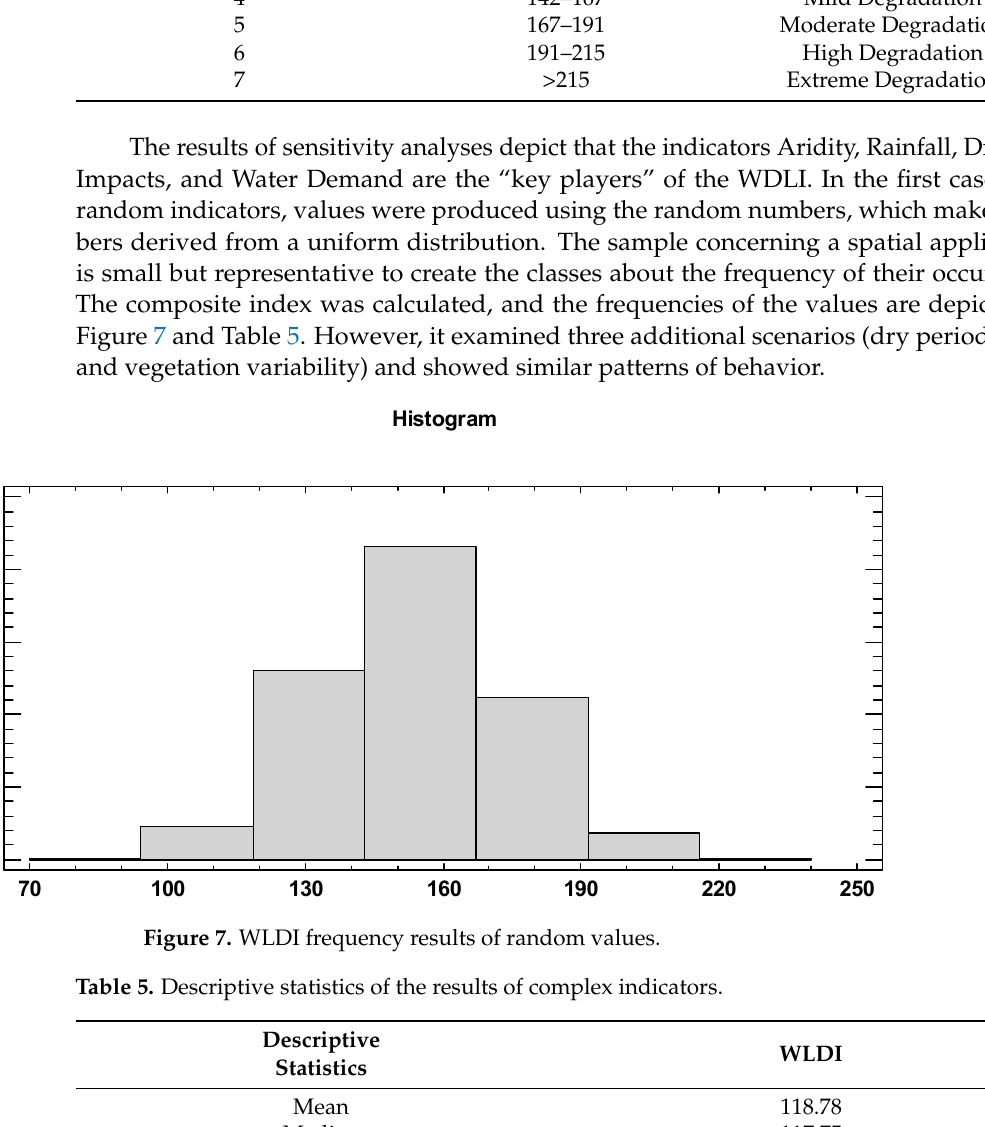
Table 4. WLDI scaled values of degradation degree [74].